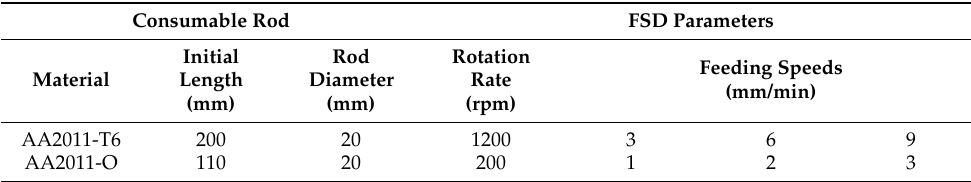
Table 2. Consumable rod dimensions and FSD processing